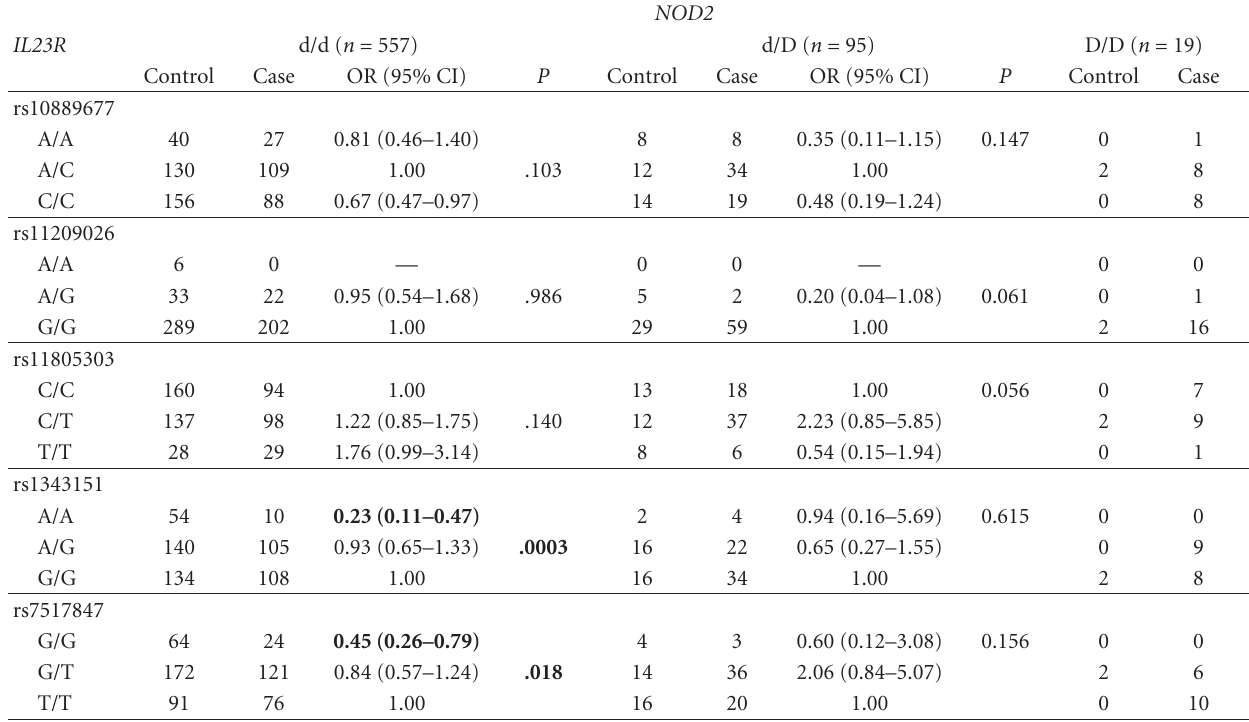
Table 5: The statistical interaction between IL23R SNPs and NOD2 genotype.